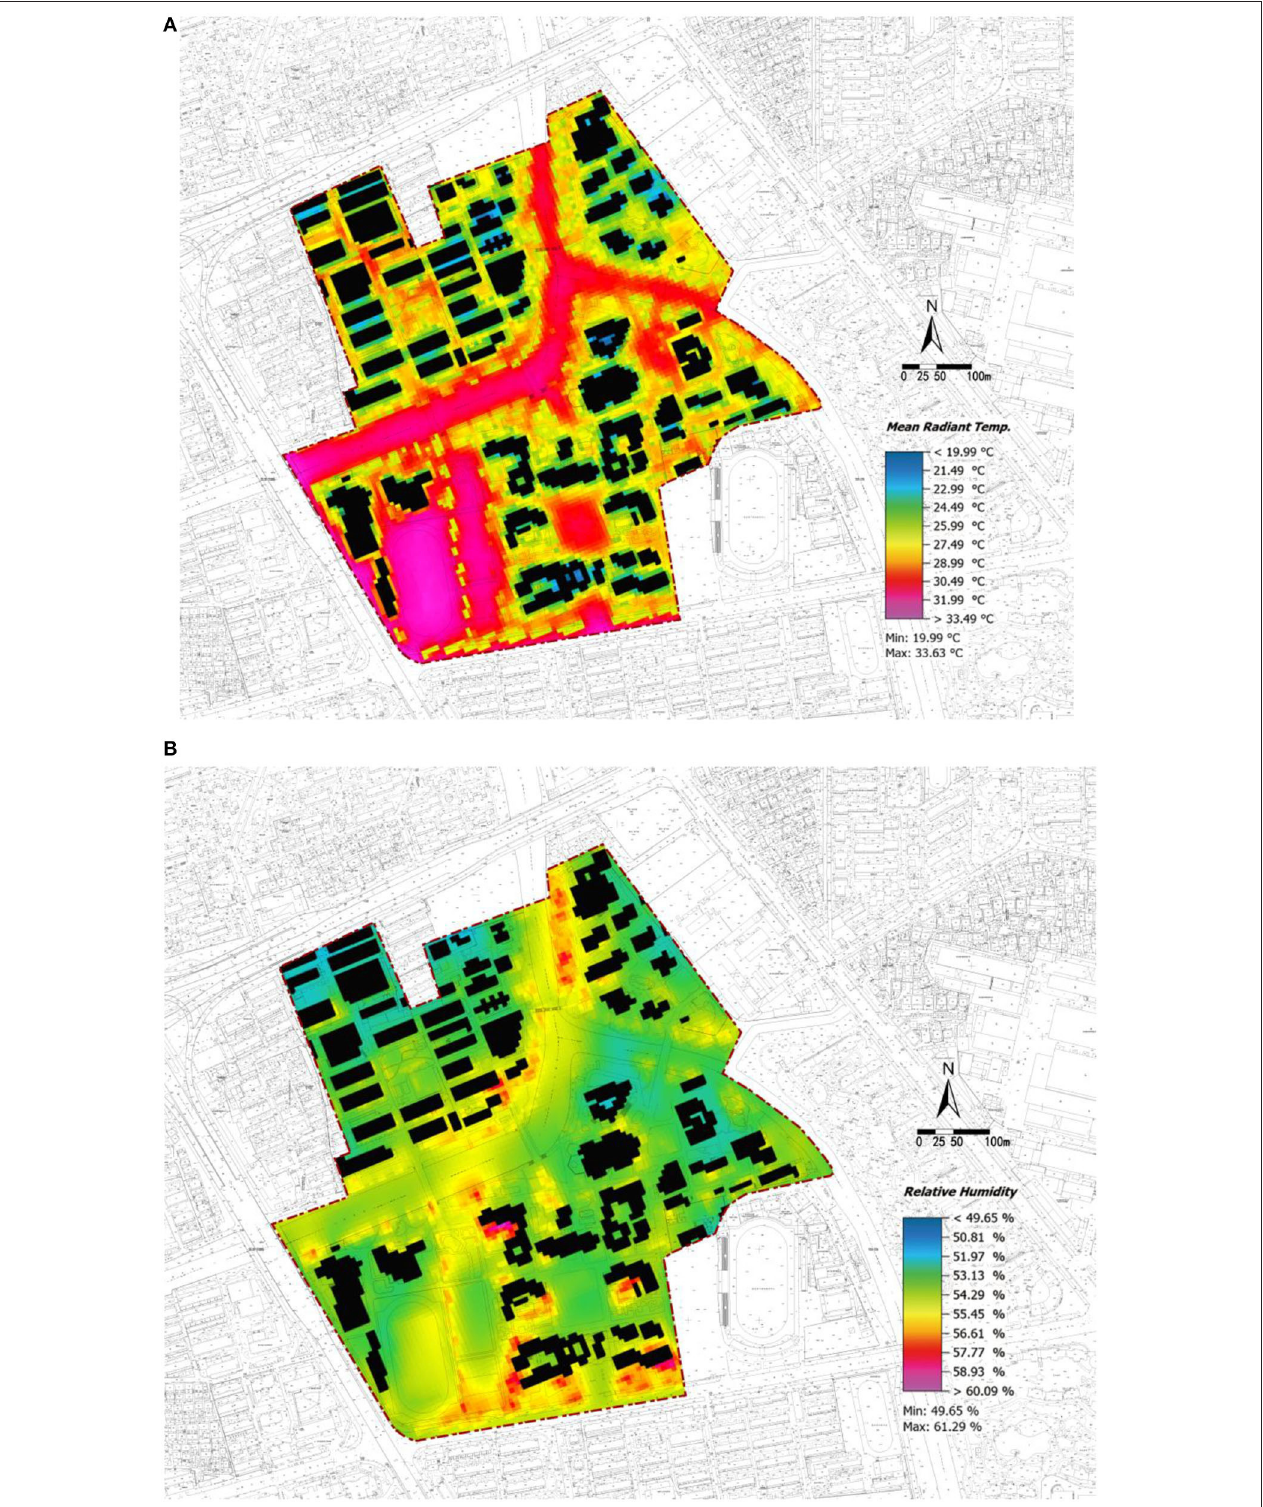
FIGURE 7 | Zhaohui Campus of Zhejiang University of Technology: Numerical simulation diagram at 14:00: (A) Mean Radiant Temp. (MRT), (B) Relative Humidity.